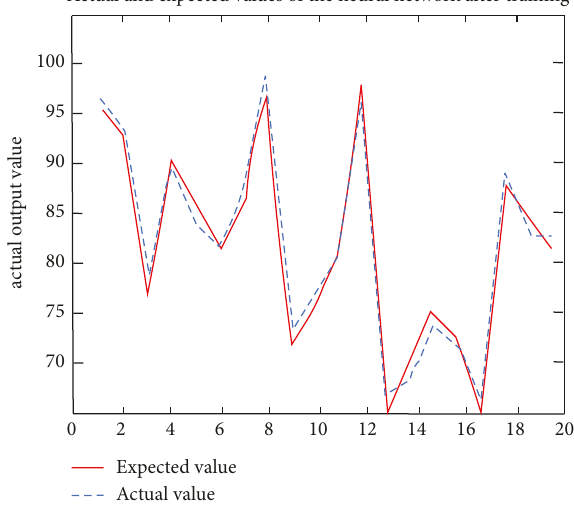
Table 4: Comparison of expected and real values.